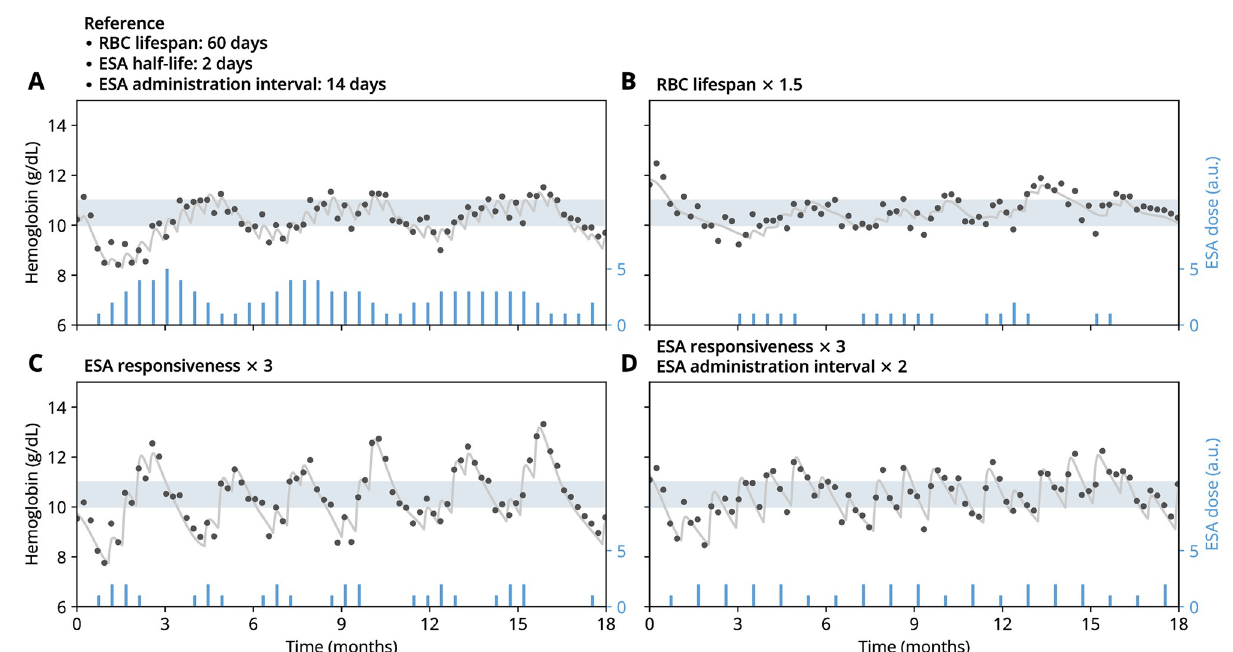
Fig 3. Simulated hemoglobin dynamics display a steady or cycling behavior, respectively, depending on physiological and treatment parameters. Plots show simulated ground-truth hemoglobin levels (gray curves), hemoglobin levels including simulated measurement errors (dots) and ESA administrations (bars). (A) Simulations with a reference parameter set (selected parameters shown above the plot, all other parameters given in Table 1). (B–D) Simulations with parameters varied with respect to the reference parameter set as indicated. In all panels, the shaded region indicates the hemoglobin target window that dose adjustments aim to reach. Initial conditions were drawn from the distribution of equilibrated states. See Methods for simulation details.